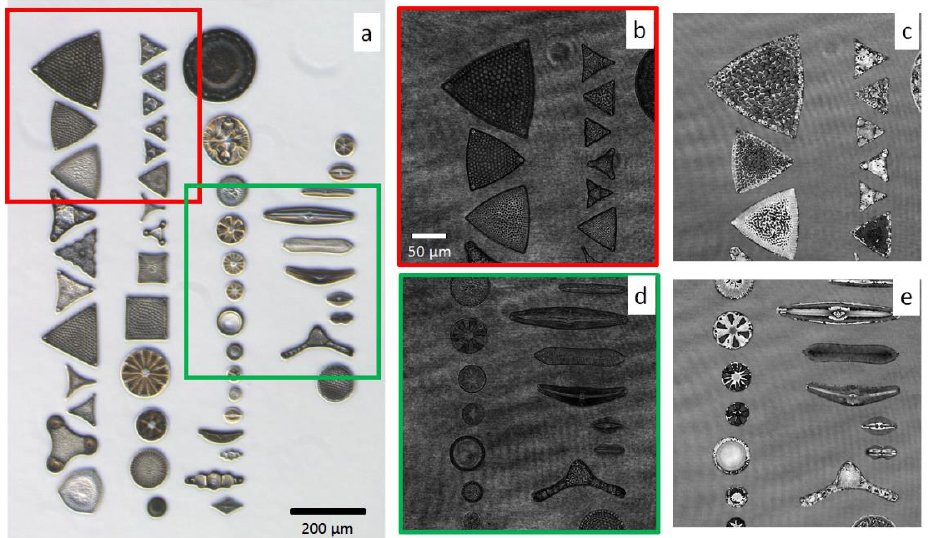
Figure 3. Holographic recording and reconstructions of diatoms within the glass slide. ( a ) Bright field image of all diatoms on the glass slide (5× commercial microscope). ( b , d ) are two recorded digital holograms within the red and green Field of View (FoV), respectively, and ( c , e ) are the corresponding wrapped quantitative phase images (WQPIs) reconstructions.